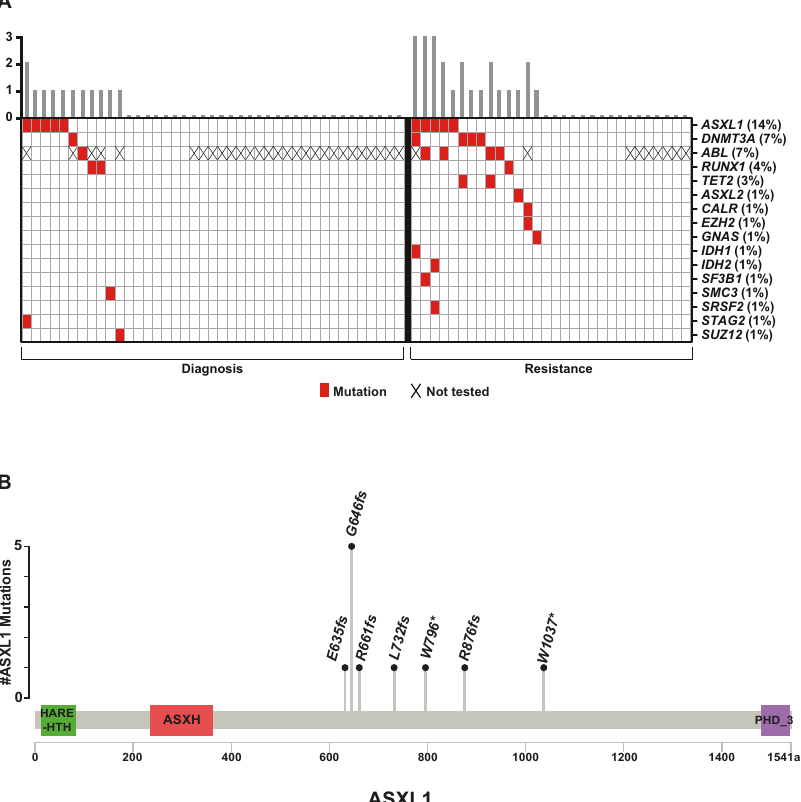
Fig. 1 Mutational pro fi le of chronic phase CML (CP-CML) patients. A Distribution of mutations in patients with CP-CML. B Frequency of various ASXL1 mutations identi fi ed. aa amino